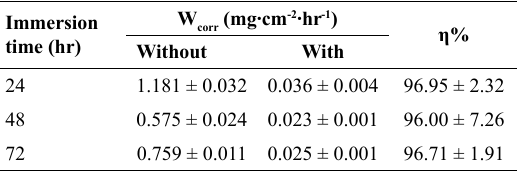
Table 5. C-steel weight loss data in 1.0 mol∙L -1 HCl without and with 100 mg∙L -1 of ethanolic Aniba canelilla extract at the following immersion times: 24, 48 and 72 hr at 25 ºC.